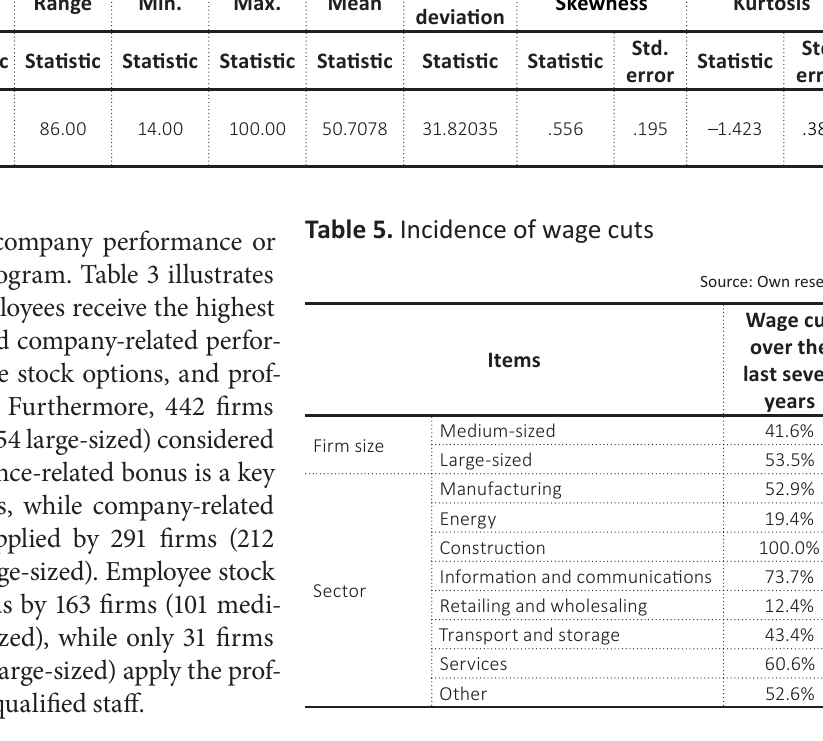
Table 4. Percentage of employees in a company who have experienced wage cut over the last seven years